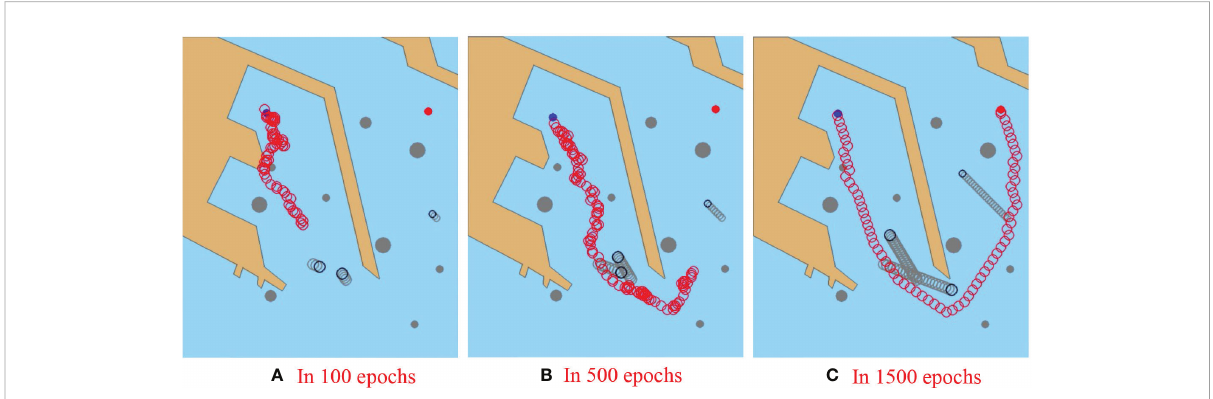
FIGURE 8 Result of collision avoidance in the static-dynamic obstacles mixed environment. Snapshots of three time-steps in simulation: (A) 100 epochs, (B) 500 epochs, and (C) 1500 epochs. The red hollow circle is the collision avoidance path of a MASS. A safety area of 5 pixels is set for the MASS to keep a safe distance from obstacles. In the training scenario, the MASS ’ s goal is to sail from the start point to the goal point